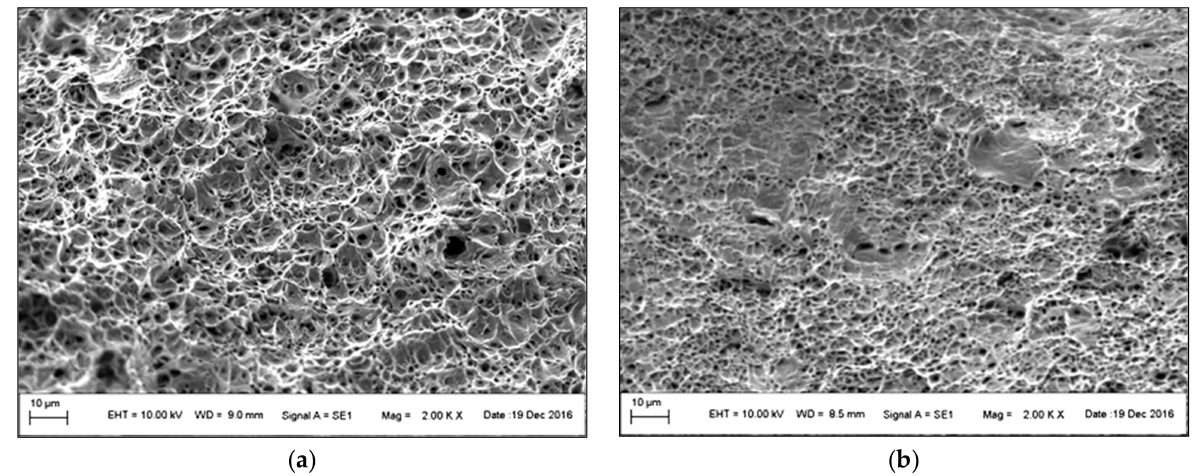
Figure 9. Fracture surface of CR180IF steel: ( a ) under static loading 8.33 × 10 − 3 s − 1 , ( b ) under dynamic loading 1200 s − 1 .